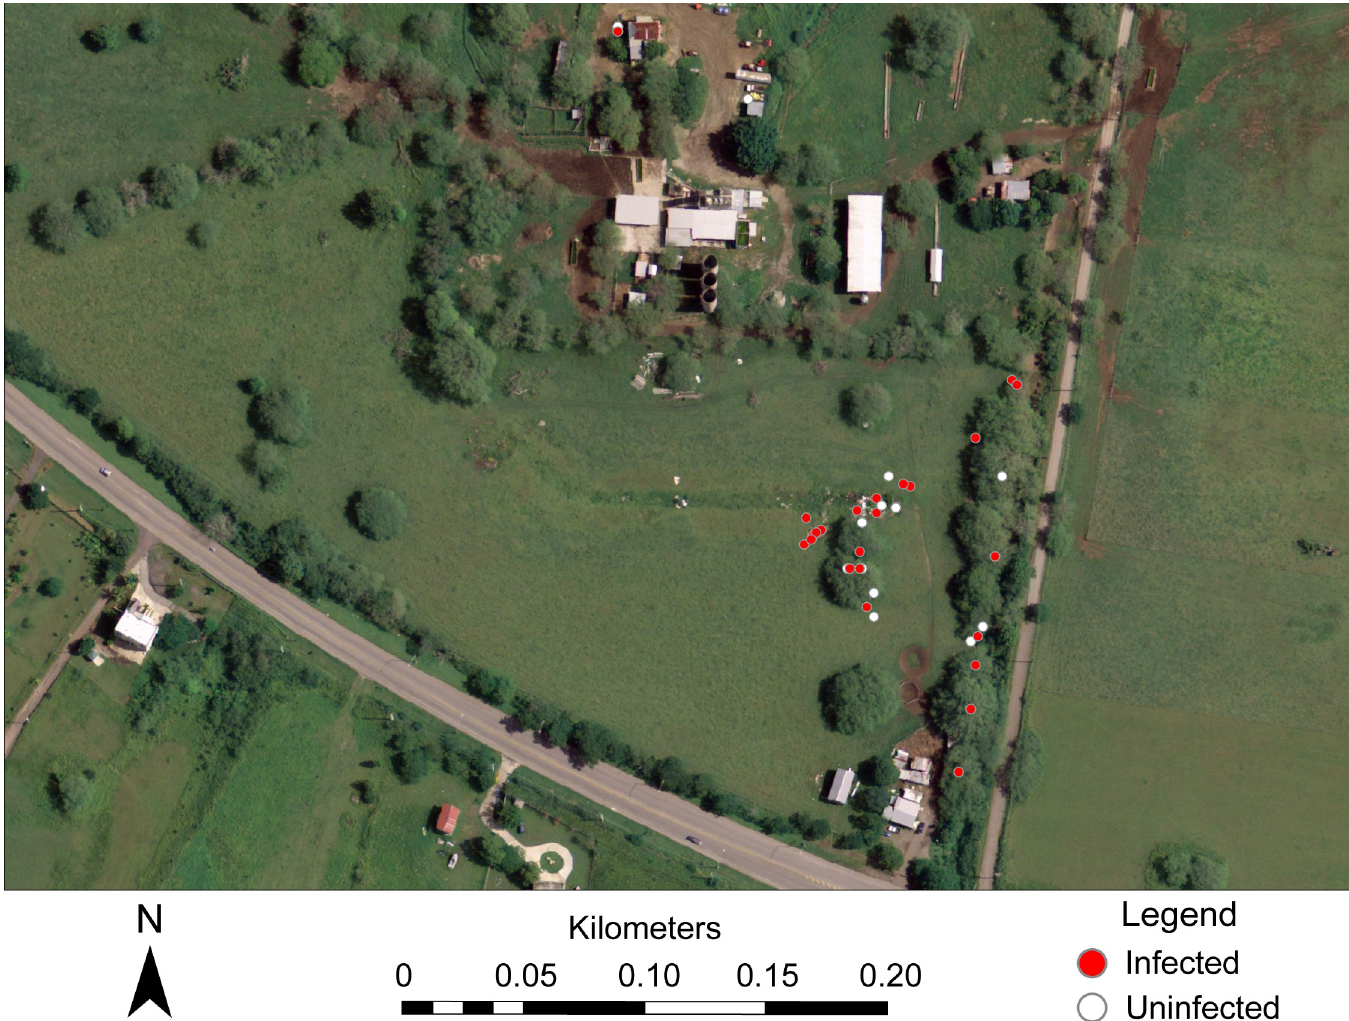
Fig 2. Potential cluster of reservoir animals ( Herpestes auropunctatus , Rattus spp., Mus musculus ) that tested positive for Leptospira at the farm location in the municipality of Lajas. Each point indicates the location of one individual. Map image includes the main milking and processing area for the farm. Structures in view include the milking area and a human dwelling. Base map for creating this figure was taken from an open source (https://datagateway.nrcs.usda.gov/GDGOrder.aspx).